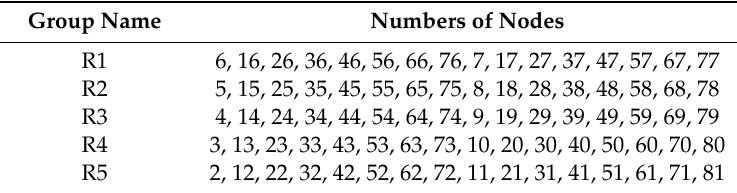
Table 5. Dome loaded with uniform snow load represented as concentrated forces.